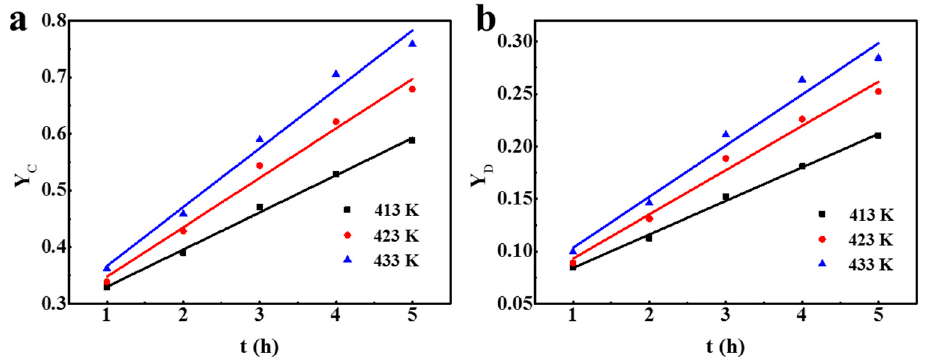
ff erent temperatures.